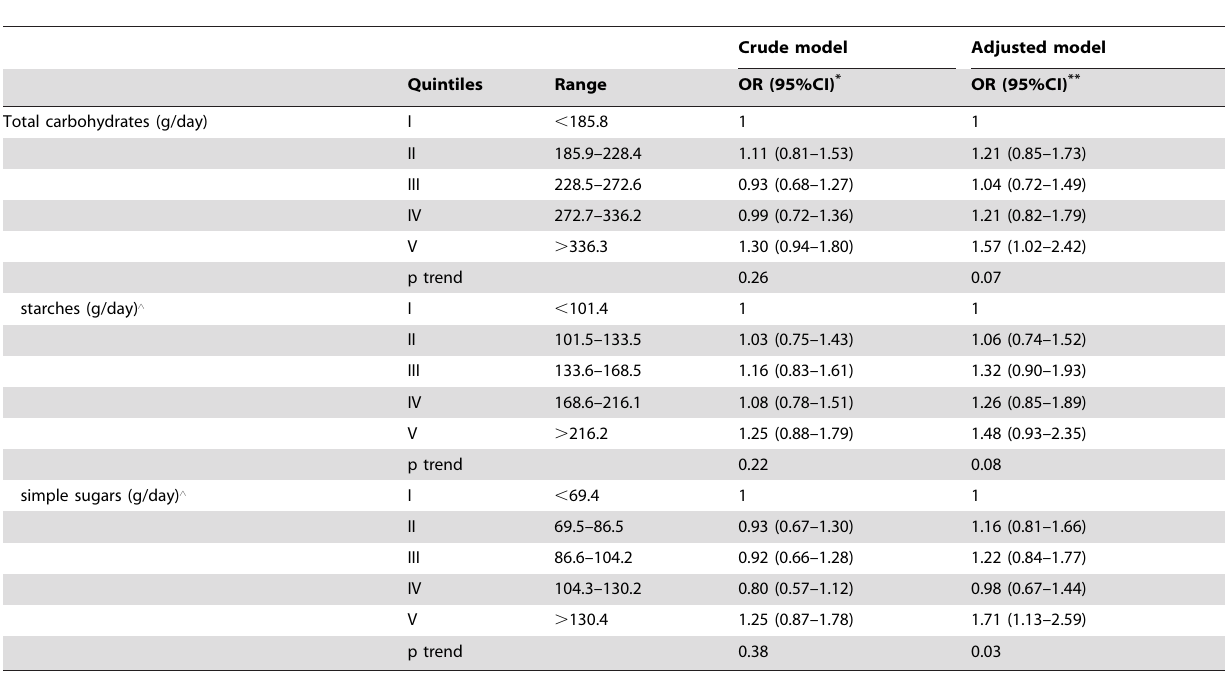
Table 4. Association between energy-adjusted total carbohydrate, simple sugars and starches and high MBD (1,628 EPIC-Florence